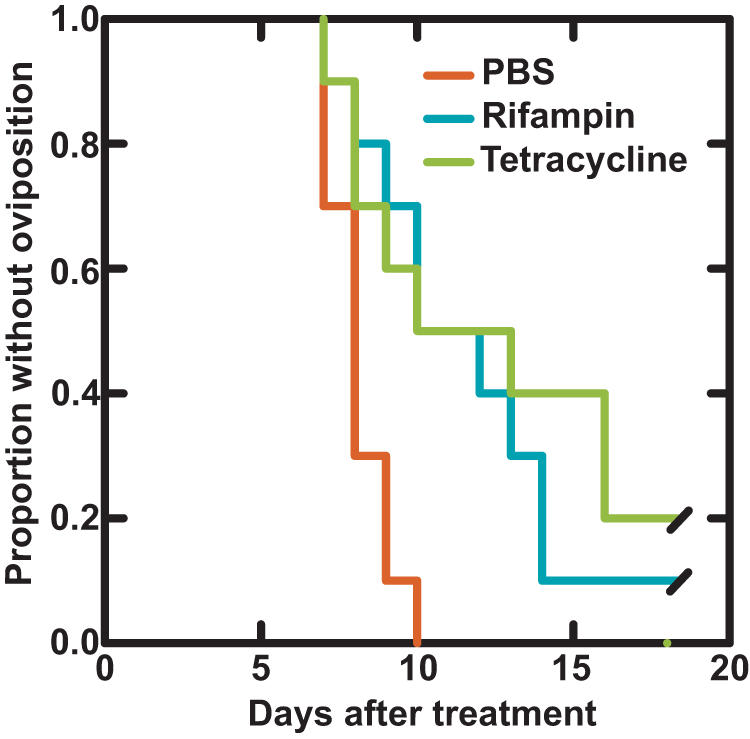
Proportion of A. americanum females without oviposition by day after treatment by injection with single doses of phosphate-buffer saline (PBS; n = 9), rifampin (n = 10), or tetracycline (n = 10). Time was censored from day 18.